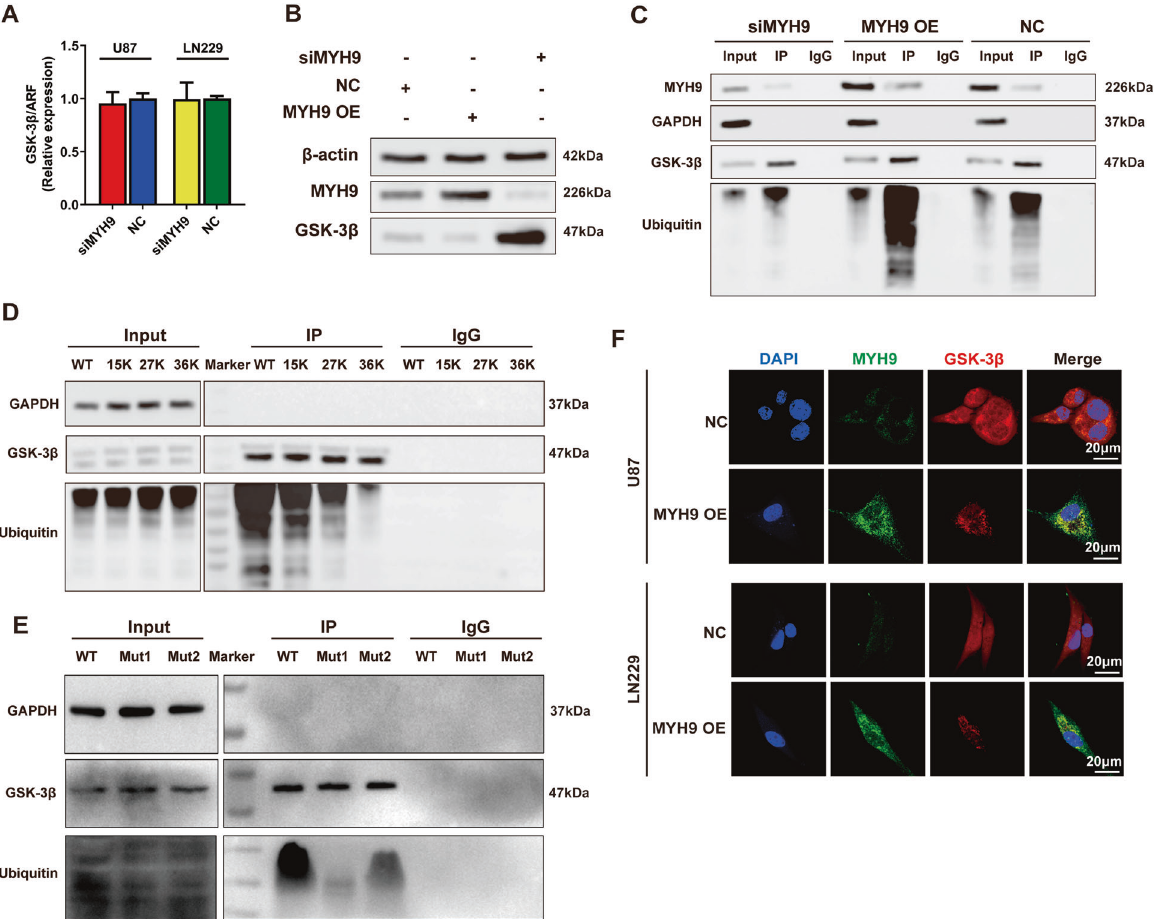
Fig. 5 MYH9 interacted with GSK-3 β and promotes its ubiquitination. A Knockdown of MYH9 had no effect on the GSK-3 β mRNA level in glioma cells. B Overexpression of MYH9 could downregulate GSK-3 β protein level and vice versa. C GSK-3 β and MYH9 proteins bind to each other, and overexpression of MYH9 downregulated GSK-3 β protein level and remarkedly increased Ubiquitin activity. D Mutation of all three potential ubiquitination sites could induce the reduction of ubiquitination of GSK-3 β . E Mutation of two potential interaction domains of MYH9 could both upregulate the GSK-3 β protein level and inhibit Ubiquitin activity. F Immuno fl uorescence staining showed MYH9 and GSK-3 β both mainly located in the cytoplasm, and overexpression of MYH9 could reduce the cytoplasmic expression of GSK-3 β